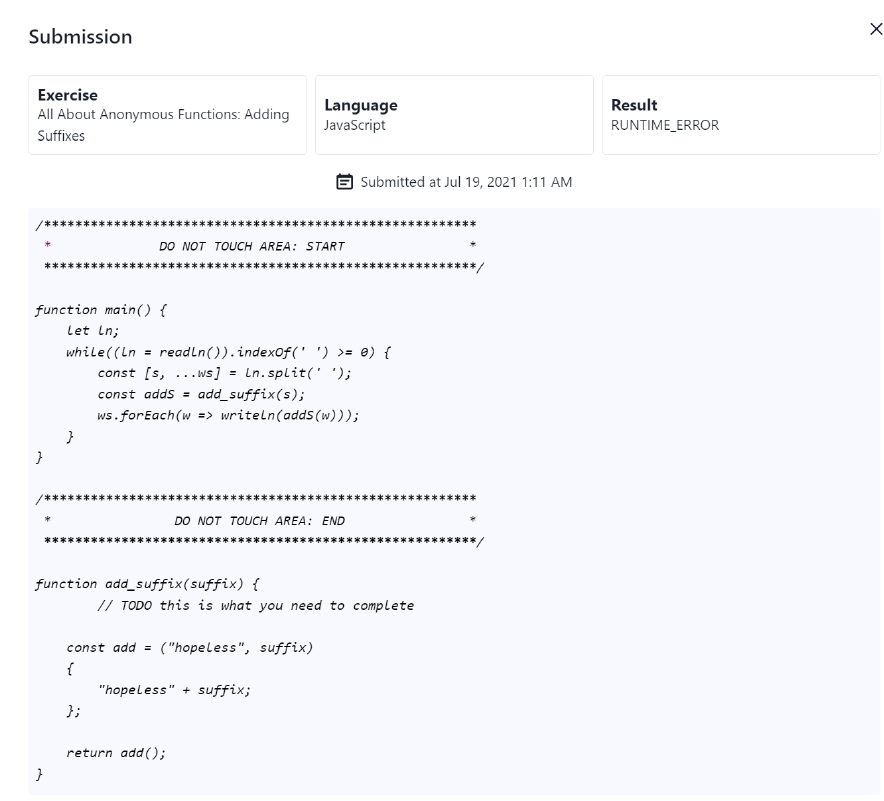
Figure 7. Exemplary screenshot of the FGPE PLE Teacher UI: submission